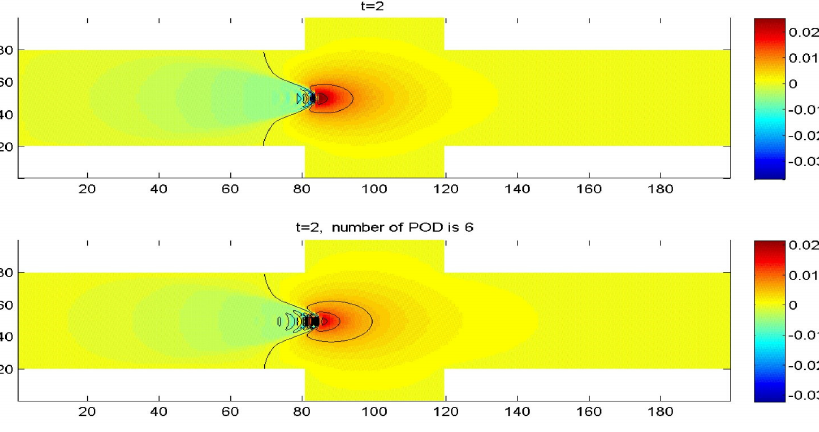
Figure 3. Top chart is the classical SCNMFE solution of pressure p and bottom chart is the POD-based reduced-order SCNMFE solution of pressure p with 6 POD bases when Re = 1000 and Pr = 7 at time t =